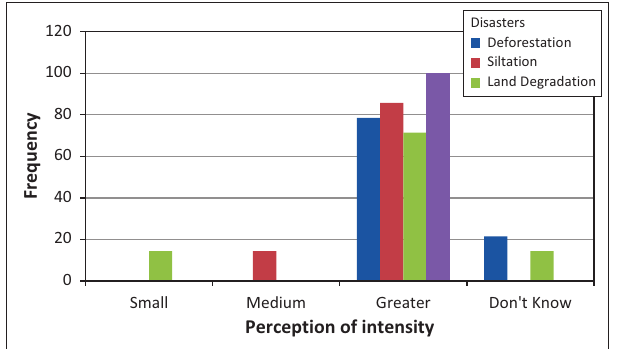
FIGURE 3: Respondents’ perception of intensity of environmental problems.